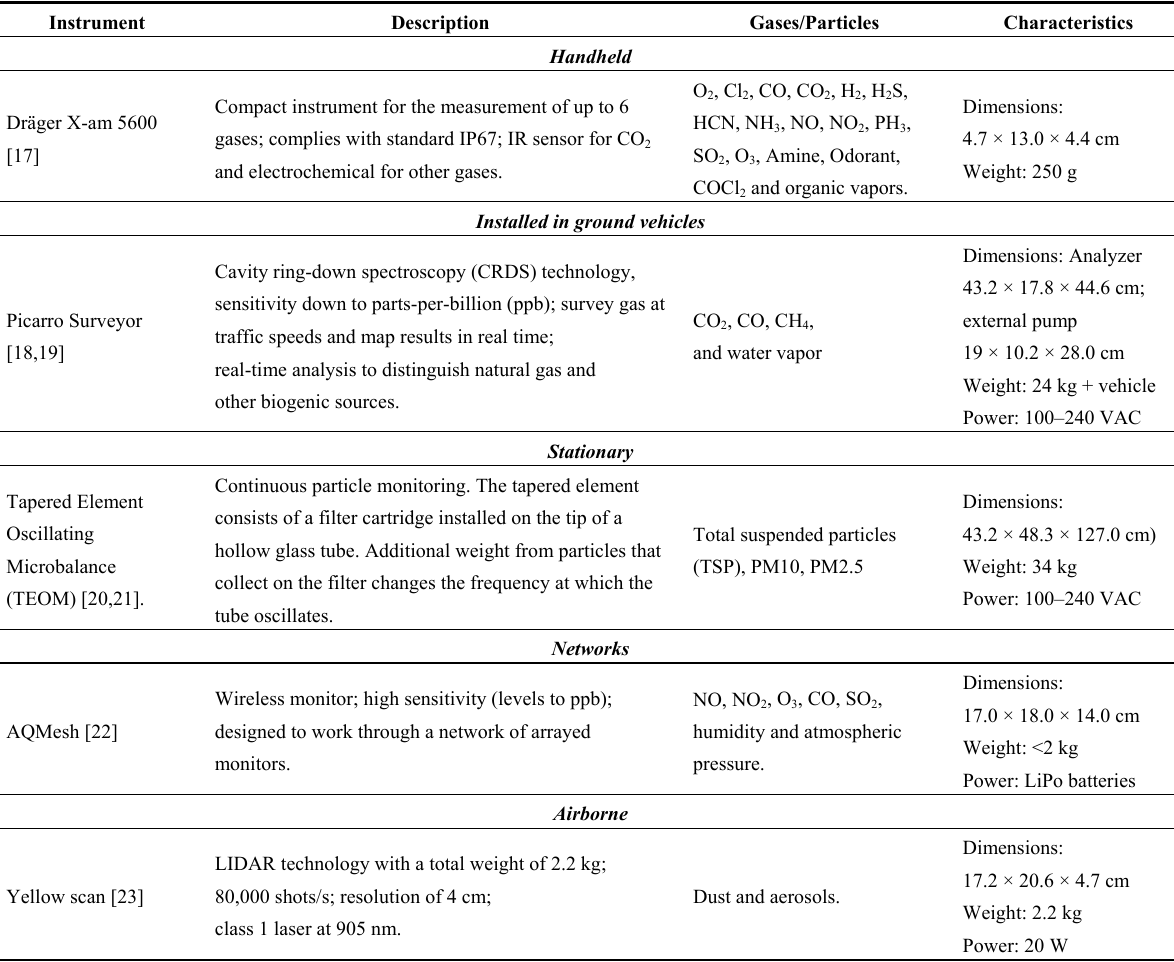
Table 1. Example of sensing technology used for monitoring gases in the mining, oil and gas